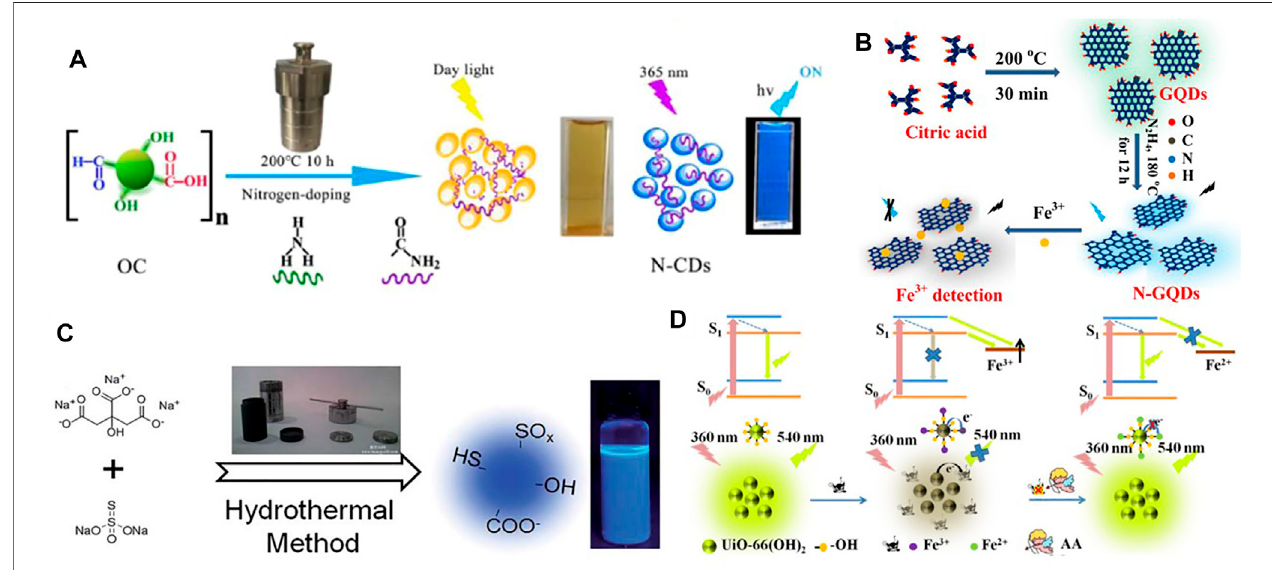
FIGURE 2 | (A) The schematic diagram of preparation of fl uorescent N-CDs via hydrothermal treatment (Liu Z. et al., 2020); (B) Schematic representation of the procedureforsynthesizingN-GQDsandthedetectionofFe 3+ (JuandChen,2014); (C) SchemeofthesynthesisofS-dopedC-dotswithblueluminescence(XuQ.etal., 2015); (D) Schematic illustration the “ on-off-on ” fl uorescent detection of Fe 3+ , AA using UiO-66-(OH) 2 as sensor (Wang H. et al.,